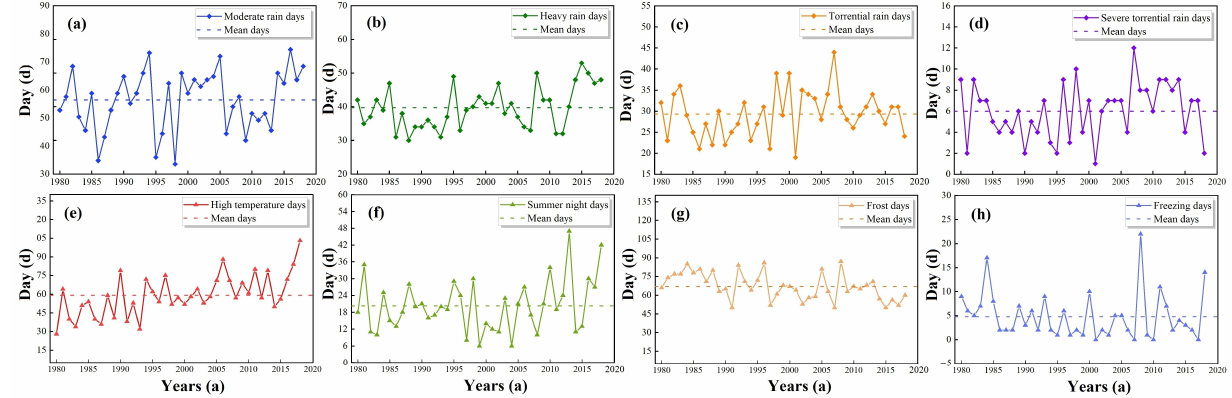
Figure 6. The annual distribution of extreme precipitation days ( a – d ) and extreme temperature days ( e – h ) from 1980 to 2018 in the TGRA. ( e – h ) from 1980 to 2018 in the